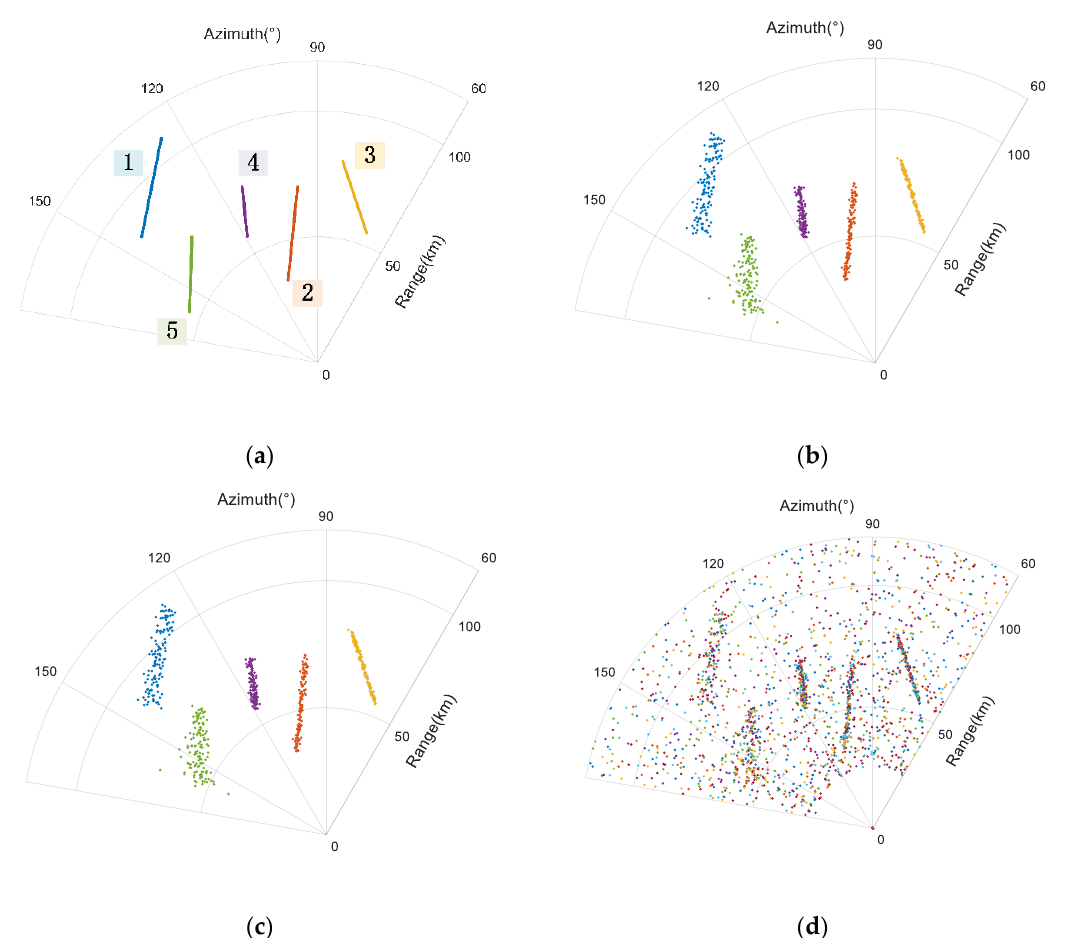
Figure 7. Production of the simulated data: ( a ) true tracks of five targets; ( b ) target tracks with measurement error; ( c ) target tracks detected; ( d ) detection results from CFAR.